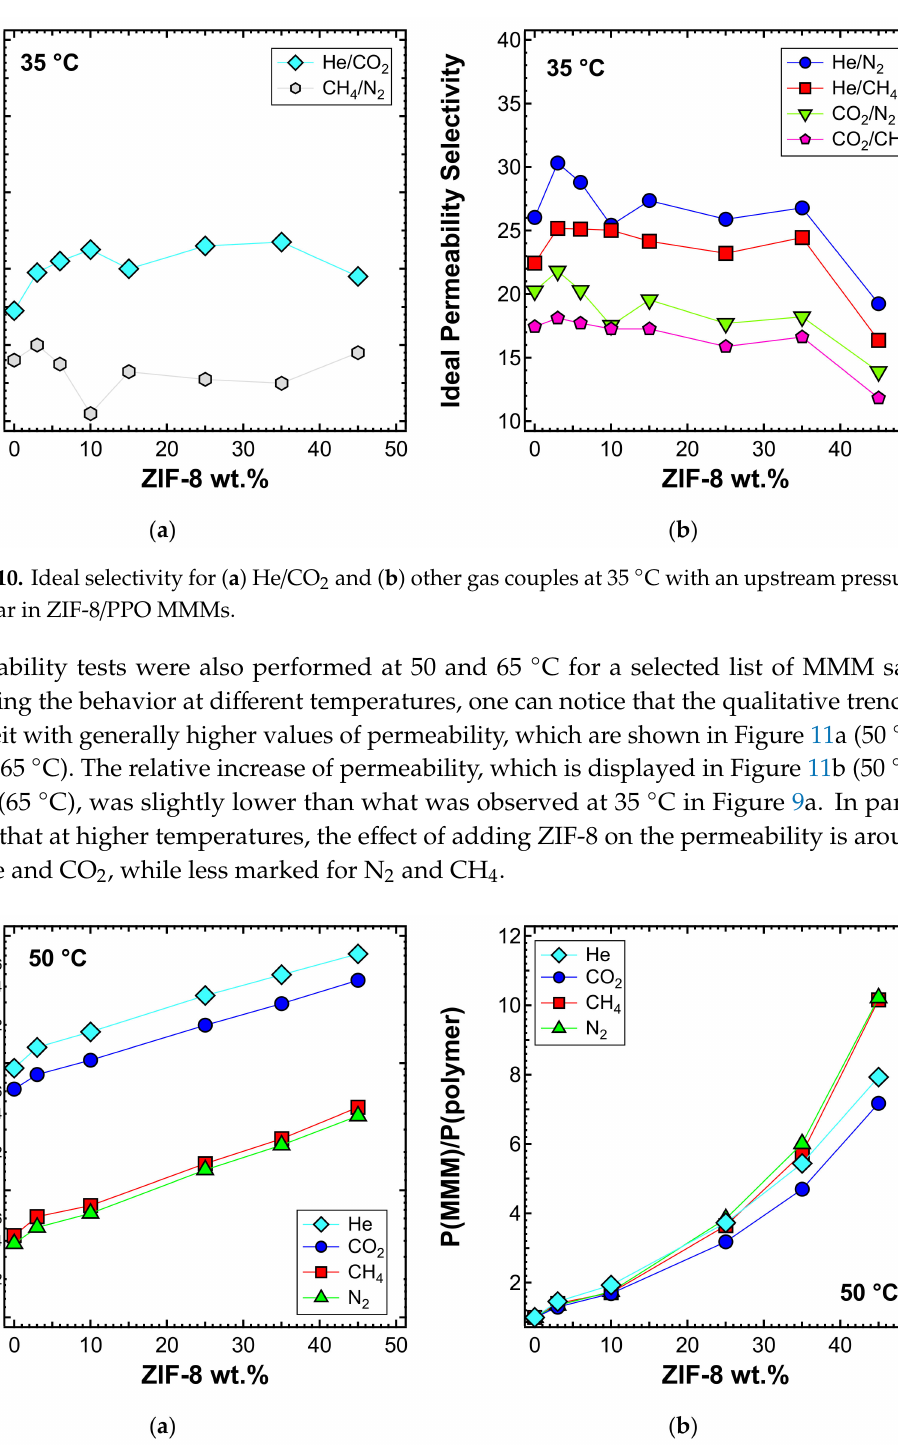
Figure 11. ( a ) Permeability and ( b ) relative permeability increase of various gases at 50 ◦ C with an upstream pressure of 1.3 bar in ZIF-8 / PPO